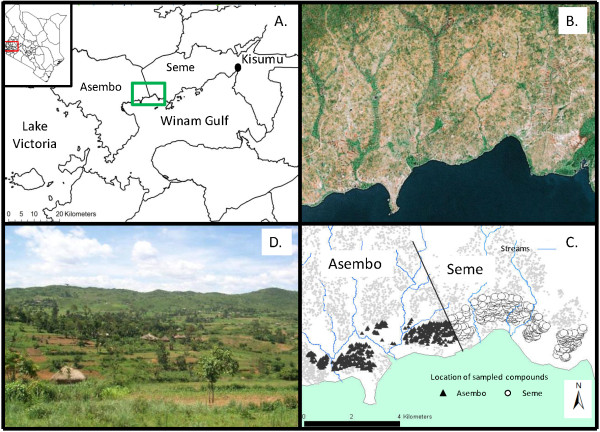
A. Location of study site in western Kenya. Small insert map shows Kenya; red box indicates study region in western Nyanza province. Locations of Asembo and Seme are indicated. Green box indicates sampling transect from 2003 to 2009 (as in B and C). B. Google Earth satellite image of transect region in the Asembo and Seme study area, showing lake plain topography, numerous stream courses, and rural agricultural landscape. C. 12 km sampling transect from Asembo into Seme, showing location of mapped, sampled compounds in 2003. D. Photograph of study area facing north, showing housing compounds, surrounding farmland, and topography.